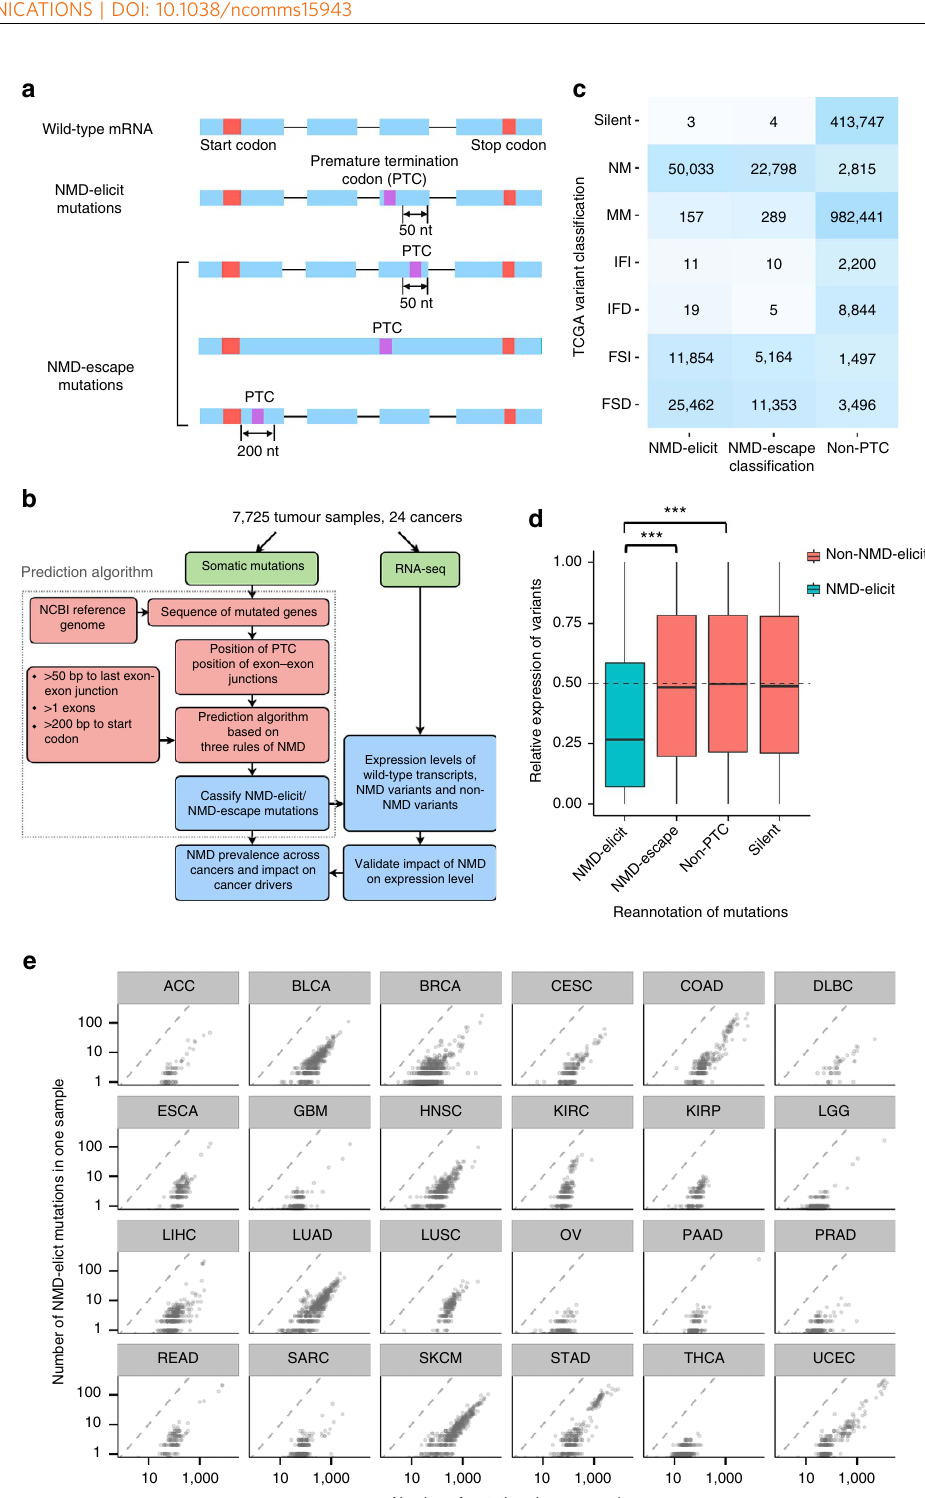
Figure 1 | The landscape of NMD-elicit mutations in cancer. ( a ) A diagram showing the three rules used to annotate NMD-elicit mutations. ( b ) A schematic showing the pipeline used for the prediction of NMD-elicit mutations in TCGA data. ( c ) A summary of the number of NMD-elicit mutations categorized by their original TCGA classification as indicated. FSD, frameshift deletion; FSI, frameshift insertion; MM, missense mutation; NM, nonsense mutation; Silent, silent mutation; IFD, in-frame insertion; IFI, in-frame insertion. ( d ) Boxplots comparing the expression levels of genes that harbour NMD-elicit (green) and NMD-escape (red) frameshift indels and nonsense mutations. The horizontal line at 0.5 indicates no differential expression. The expressions in the NMD-elicit group ( N ¼ 53,406) are significantly lower than those in the NMD-escape ( N ¼ 19,773), non-PTC- harbouring ( N ¼ 488,430) or silent ( N ¼ 202,508) groups (median ratio of REV ¼ 0.54; *** P o 2.2e (cid:2) 16, one-sided t -test). ( e ) Scatter plots showing the correlation between the number of all mutations in a sample and the number of NMD-elicit mutations for each tumour type as indicated. The grey dashed lines are the angle bisectors of the first